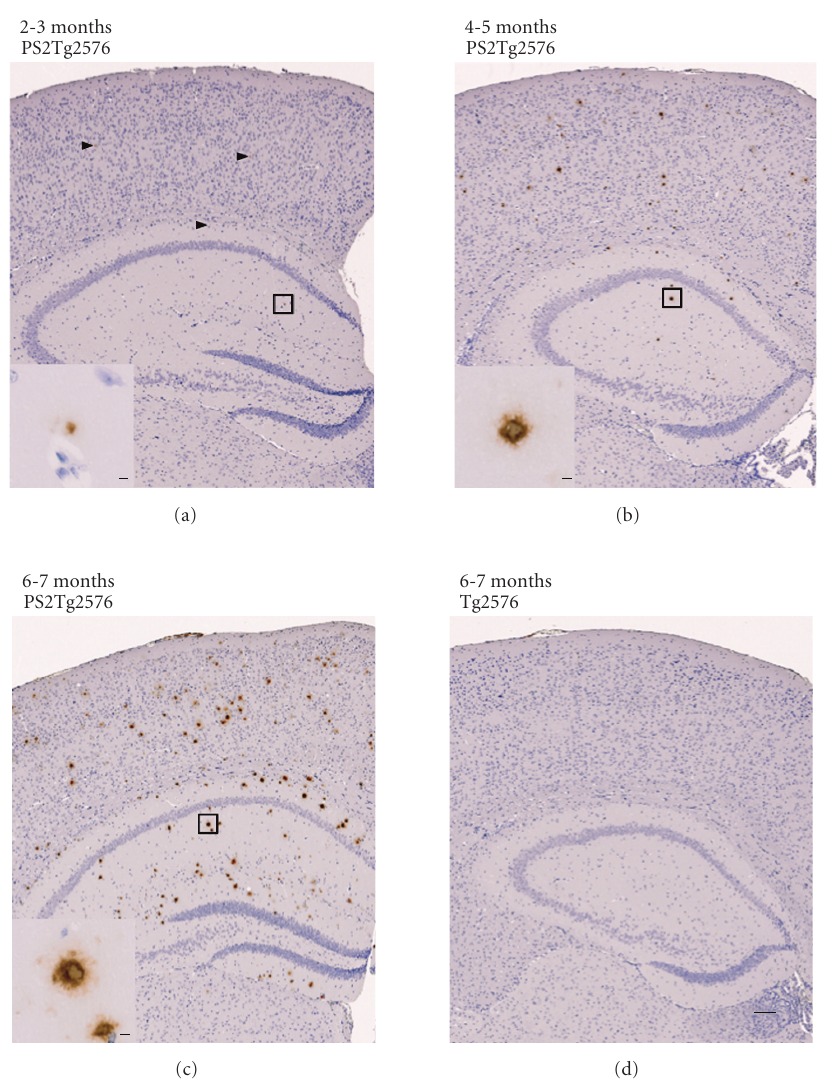
Figure 1: Early accumulation of amyloid deposition in the brains of PS2Tg2576 mice. Amyloid plaques were immunoreacted with the 82E1 monoclonal antibody against the N-terminal of A β. (a) At 2-3 months of age, typical amyloid plaques were positively detected in PS2Tg2576 mouse brains. (b) At 4-5 months, amyloid depositions were significantly observed in the hippocampus and the cerebral neocortex of the PS2Tg2576 mice. (c) In the 6-7 month-old PS2Tg2576 mice, markedly high levels of typical amyloid plaques were observed. (d) No plaques were detected in the brains of the Tg2576 mice at 6-7-months of age. The insets show a high magnification image of the boxed area. The arrowheads indicate plaques in the PS2Tg2576 mice at 2-3 months of age. The scale bars represent 200 μ m and 5 μ m in the main panel and inset,